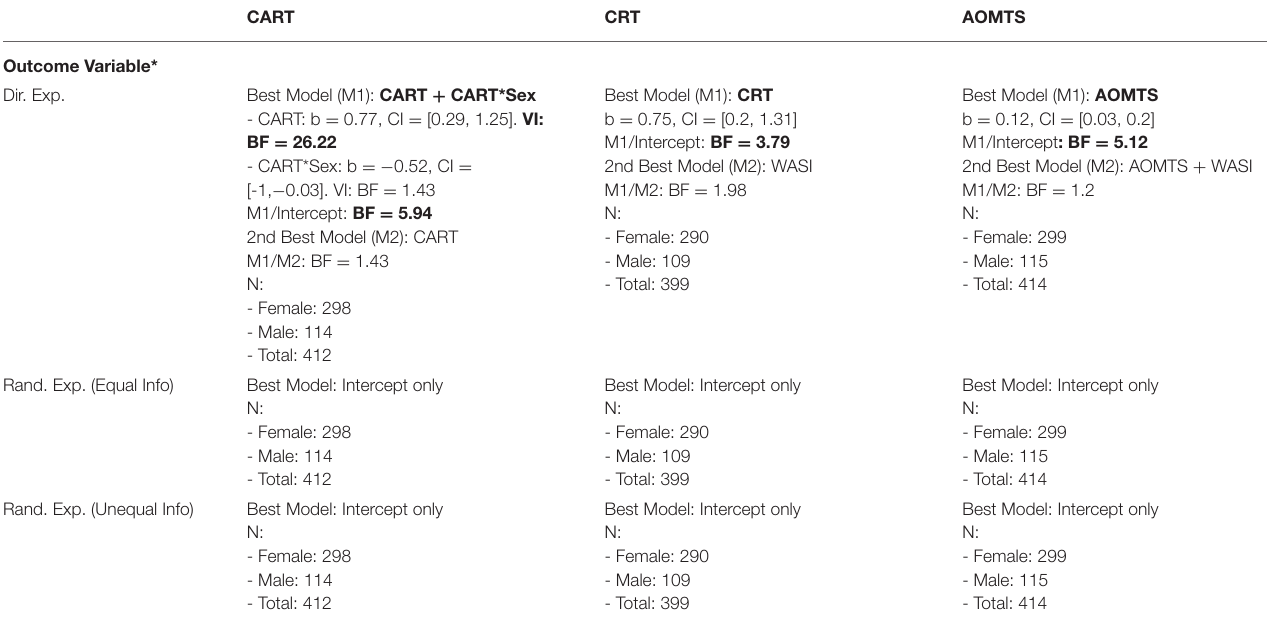
TABLE 5 | Cognitive reflection as a predictor of exploration. CART CRT AOMTS Outcome Variable* Dir.